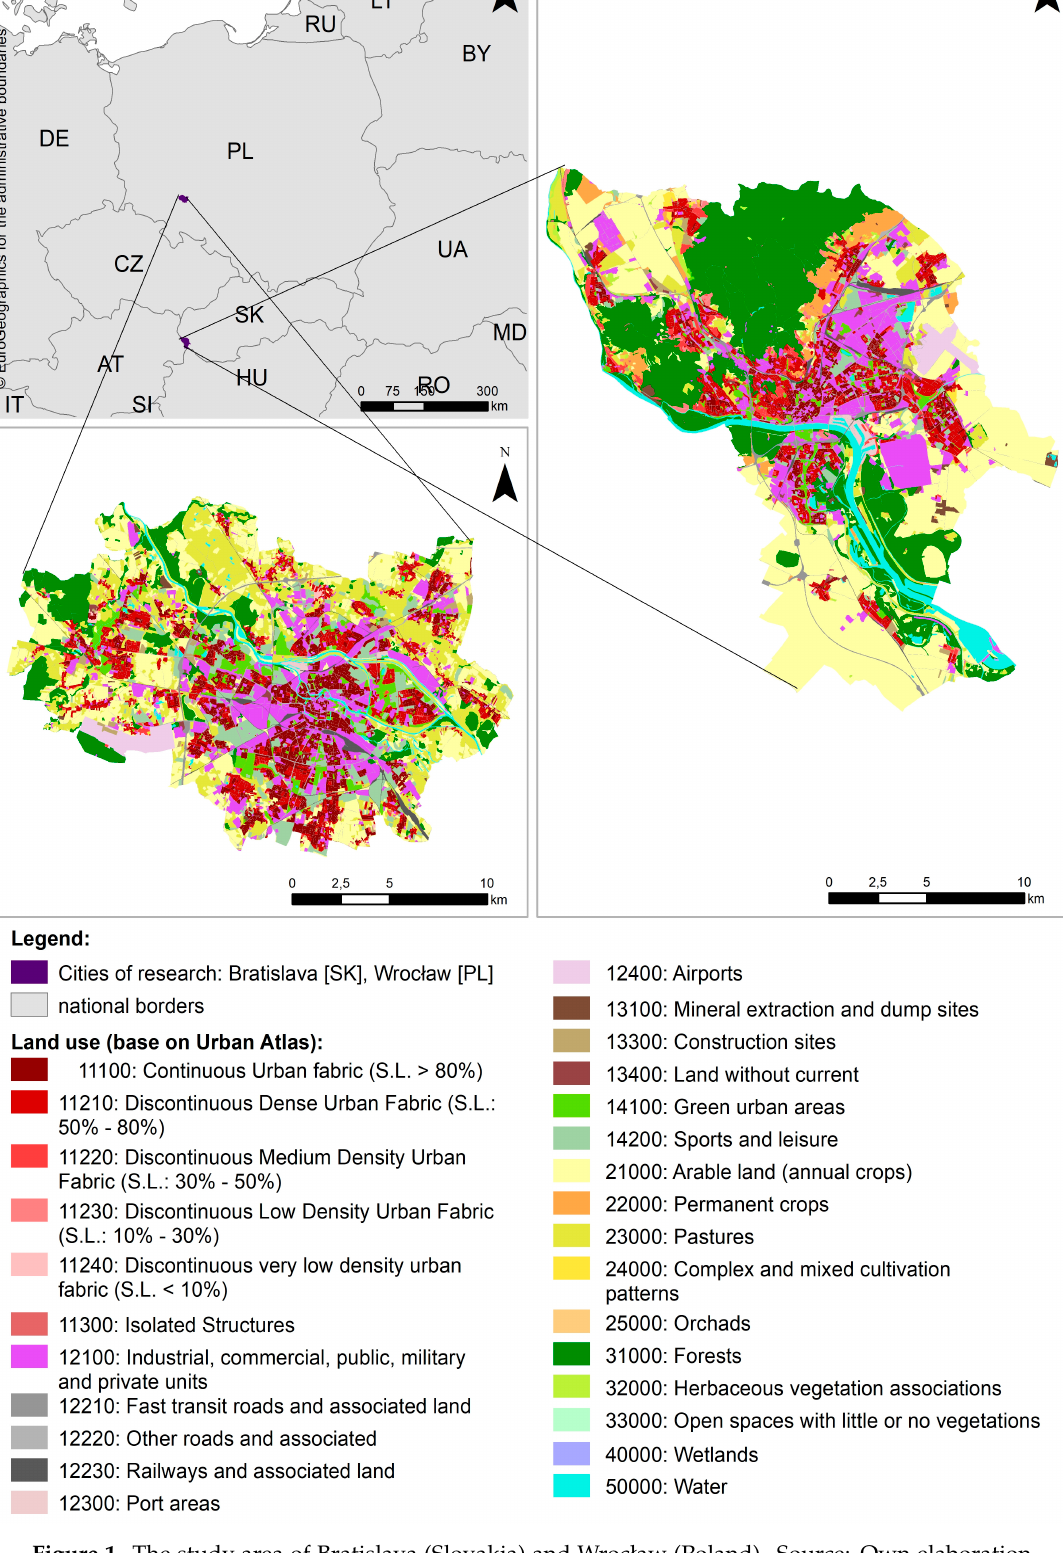
Figure 1. The study area of Bratislava (Slovakia) and Wrocław (Poland). Source: Own elaboration using ArcGIS (Esri, Redlands, CA, United States).